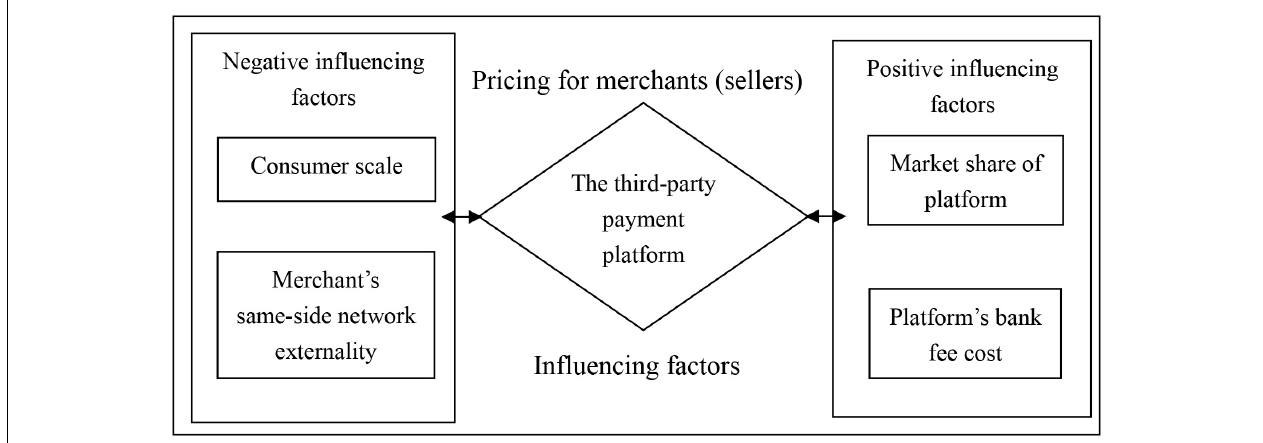
FIGURE 2 | Influencing factors for third-party payment platform pricing to